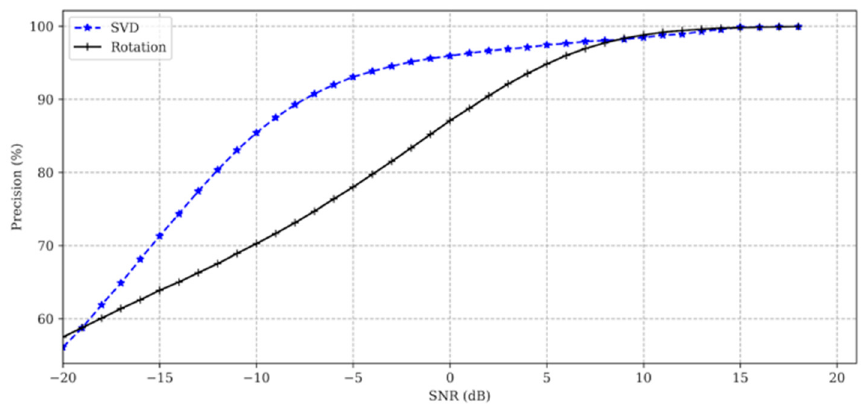
Figure 5. Precision of predictions.